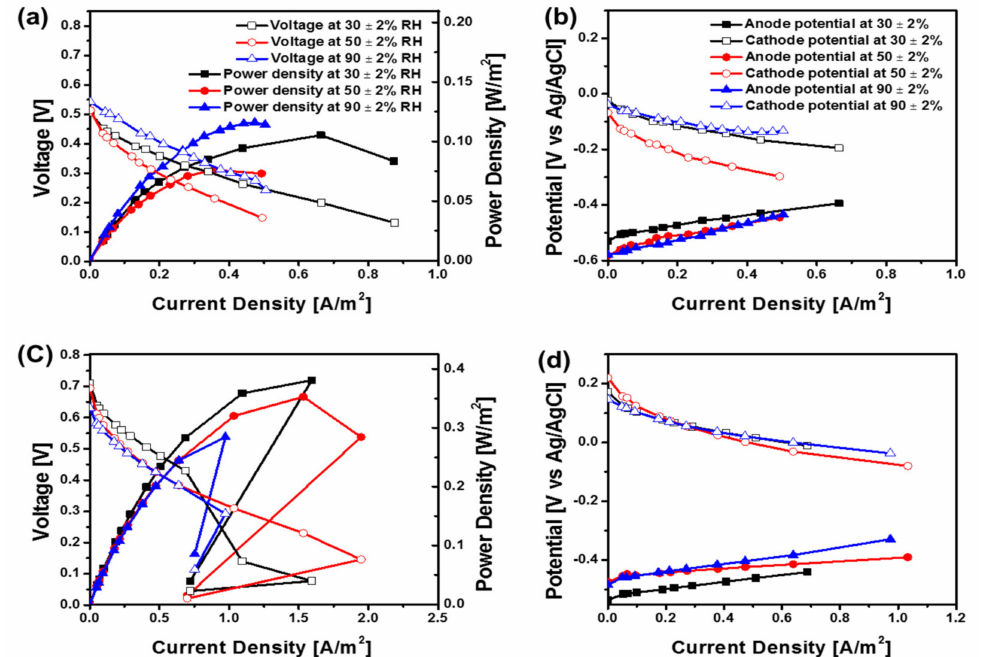
Figure 3. I-V and polarization curve of a single chamber air cathode MFC using ( a ) Nafion 117 and ( c ) PP80 at di ff erent relative humidity conditions. Variation in individual electrode potentials in relation to current densities by using ( b ) Nafion 117 and ( d ) PP80 as a